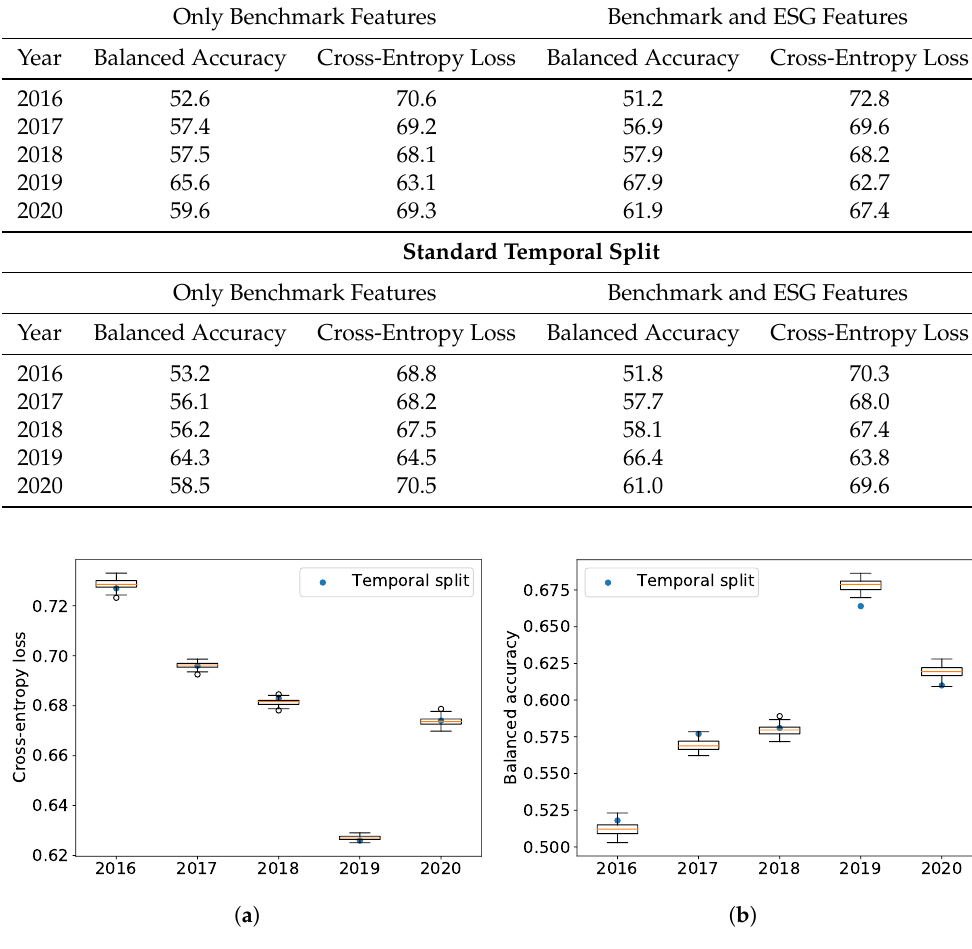
Figure 7. Performance measures on the test sets of the two train and validation schemes. The boxplots show the performance of 100 random samplings of 5 models among 100 random company-wise validation splits. ( a ) Cross-entropy in percentage; ( b ) Balanced accuracy in